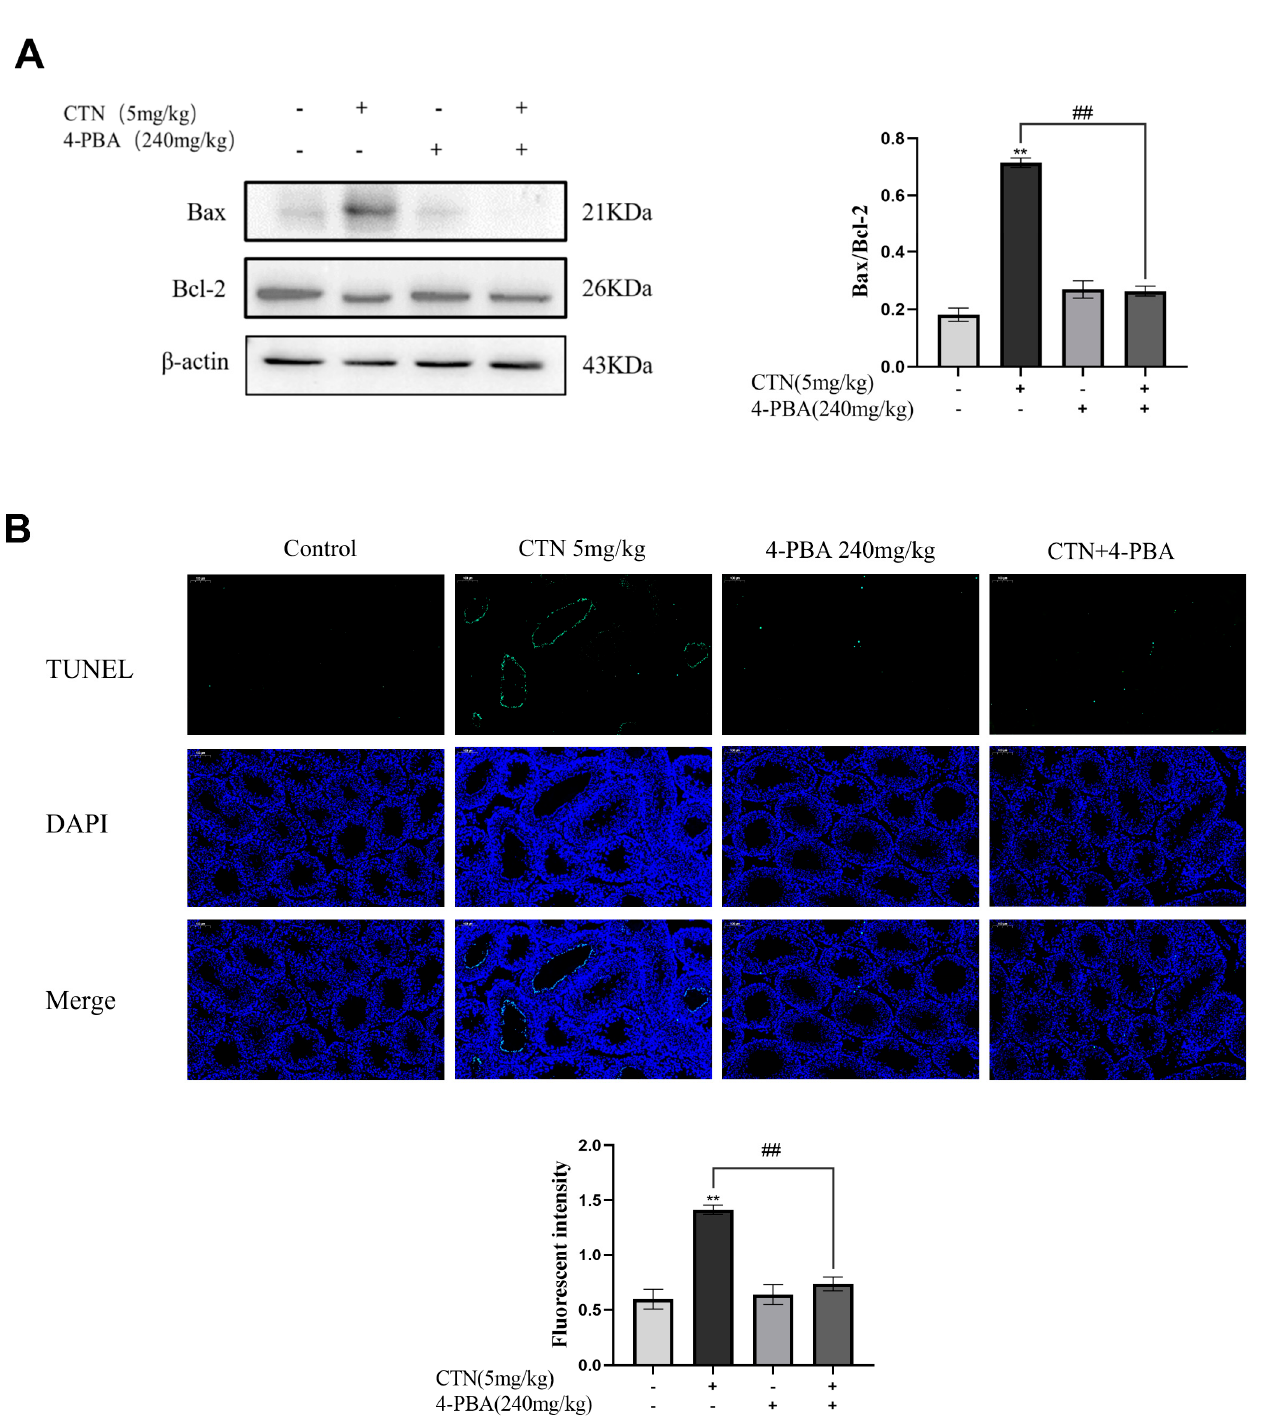
Figure 6. The effects of 4-PBA on CTN-induced apoptosis in testicular cells. ( A ) Bax, Bcl-2 protein expression levels; ( B ) TUNEL assay for testicular apoptosis. The above data are expressed as SEM ± mean, ** p < 0.01, compared with the control group, ## p < 0.01, compared with the CTN group.